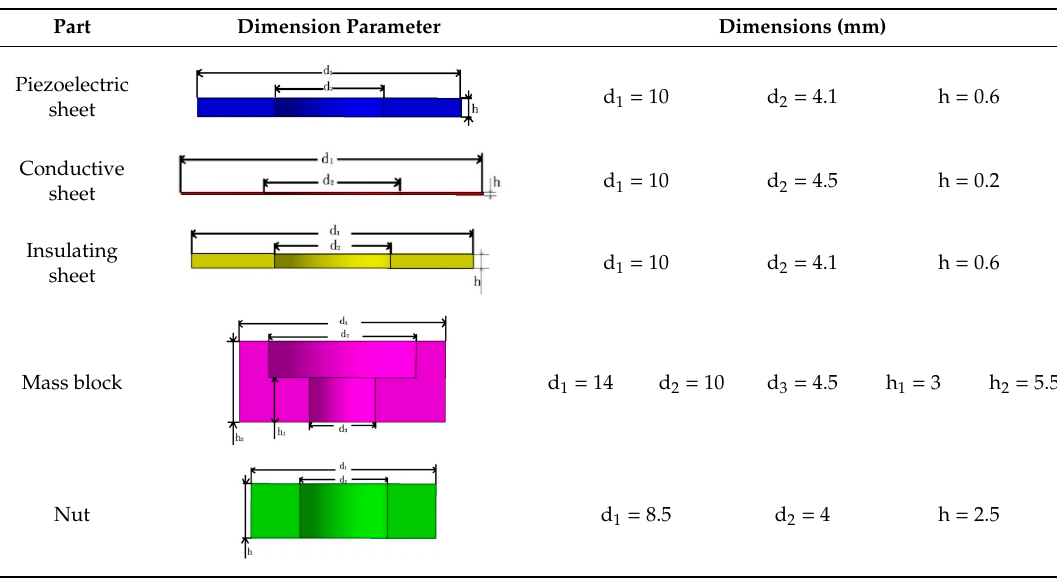
Table 1. Geometric dimensions of parts in sensing system.